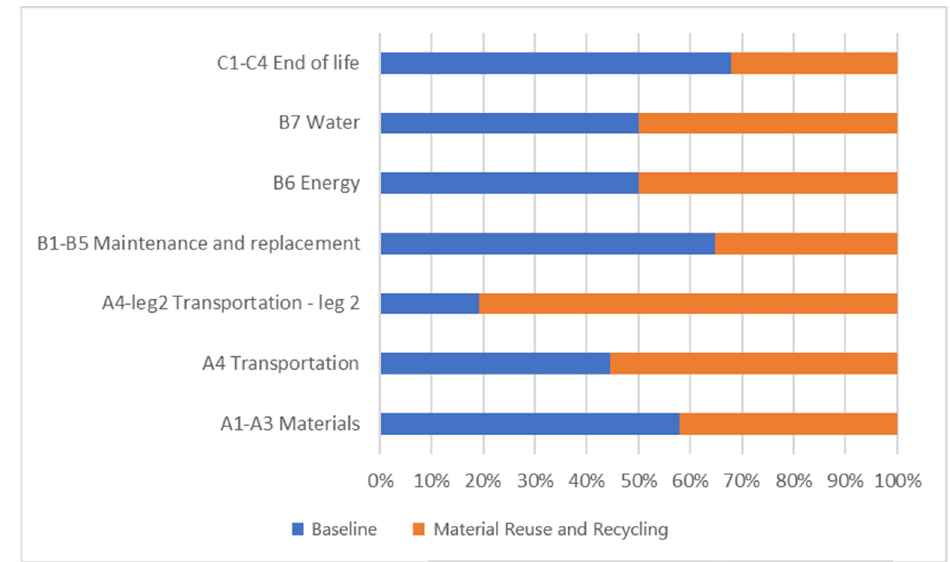
Figure 6. Comparison between baseline and material reuse and recycling on the different life cycles.